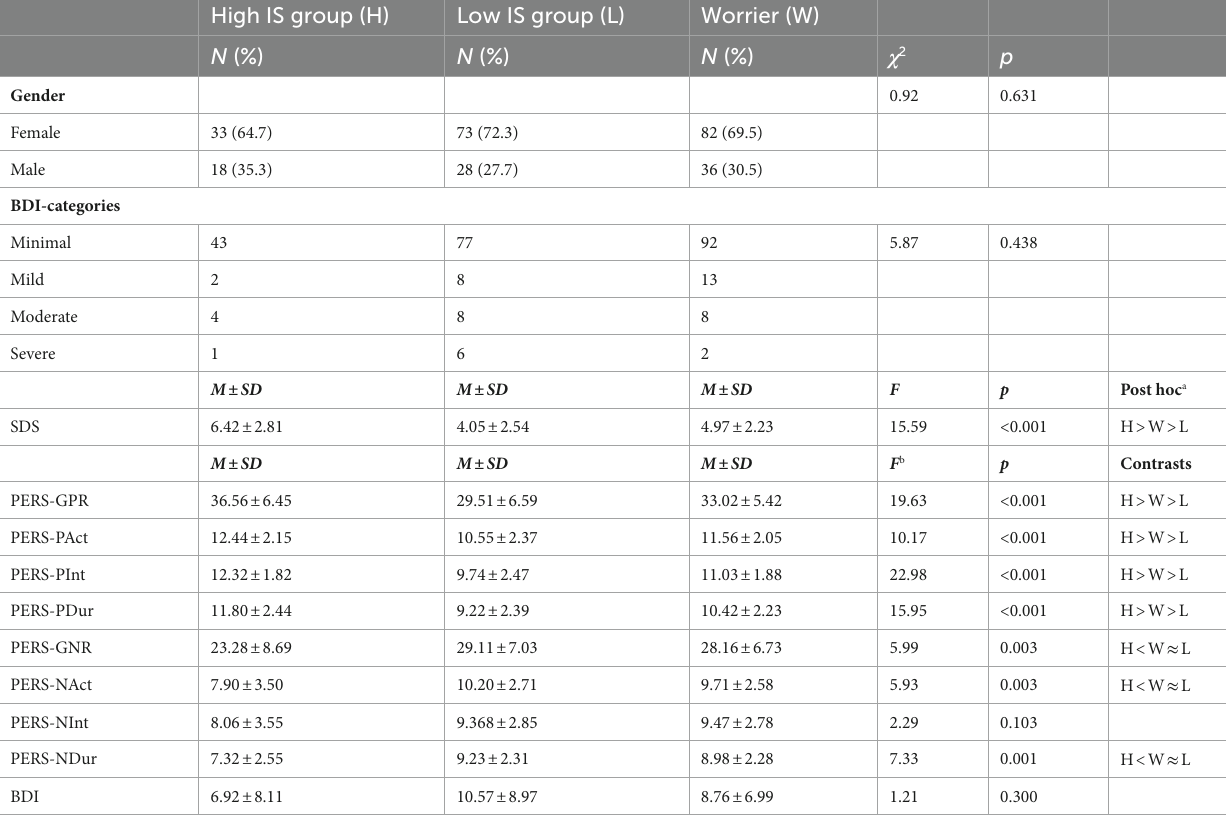
TABLE 3 Differences between three IS